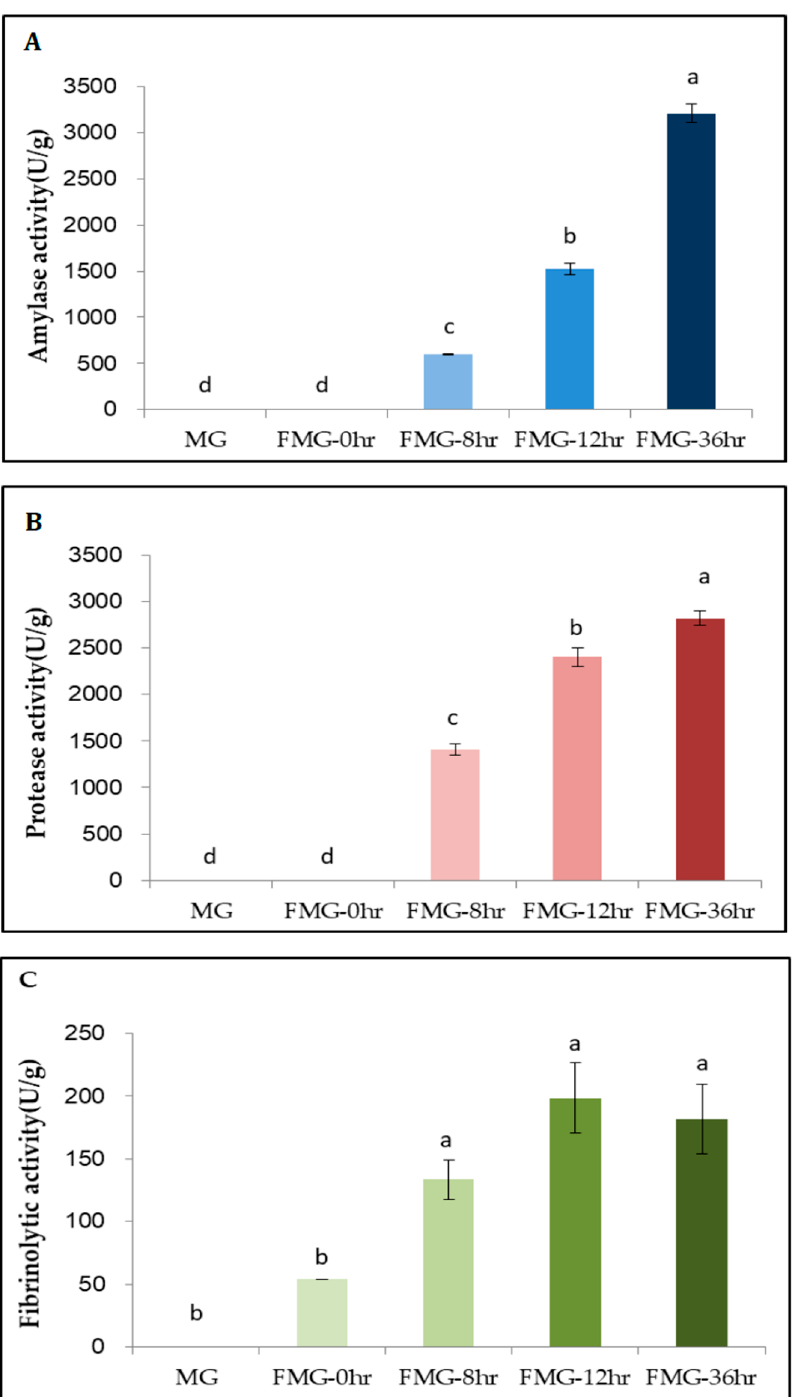
Figure 4. Enzymatic activity during MG fermentation. ( A ) Amylase, ( B ) protease, and ( C ) fibrinolytic activities were measured in each extracted sample. MG, a grain mixture before steaming; FMG-0hr, a mixture of grain steamed for 30 min at 100 ◦ C; FMG-8hr, a mixture of grain fermented for 8 h; FMG-12hr, a mixture of grain fermented for 12 h; and FMG-36hr, a mixture of grain fermented for 36 h. Data from one representative experiment of three independent experiments were presented as the mean with standard deviation of three technical replicates. Values with di ff erent letters are significantly di ff erent with p < 0.05 according to Duncan’s multiple-comparison test.